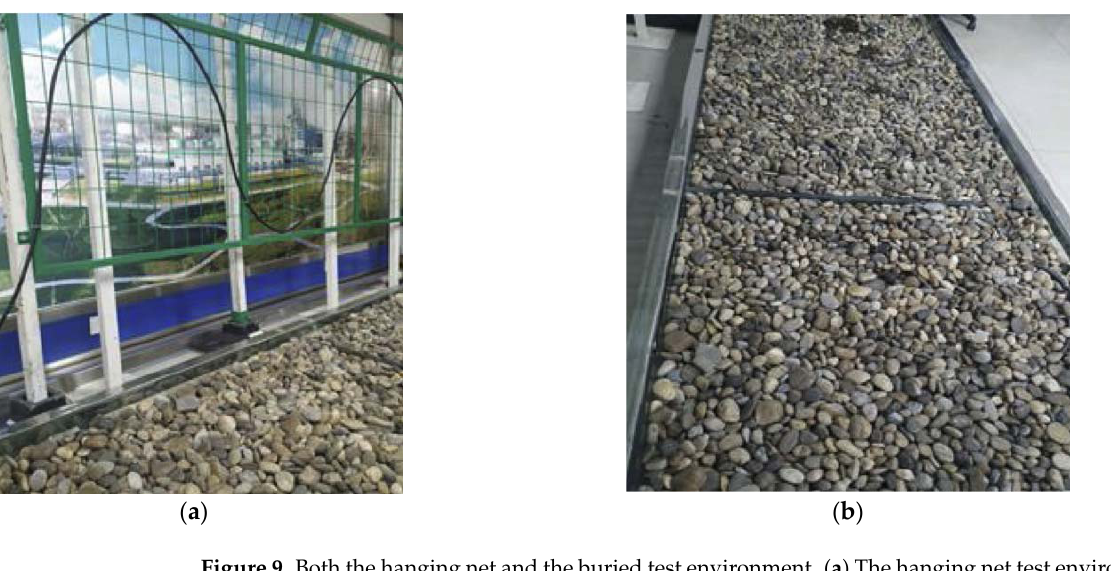
Figure 9. Both the hanging net and the buried test environment . ( a ) The hanging net test environ- ment; ( b ) the buried test